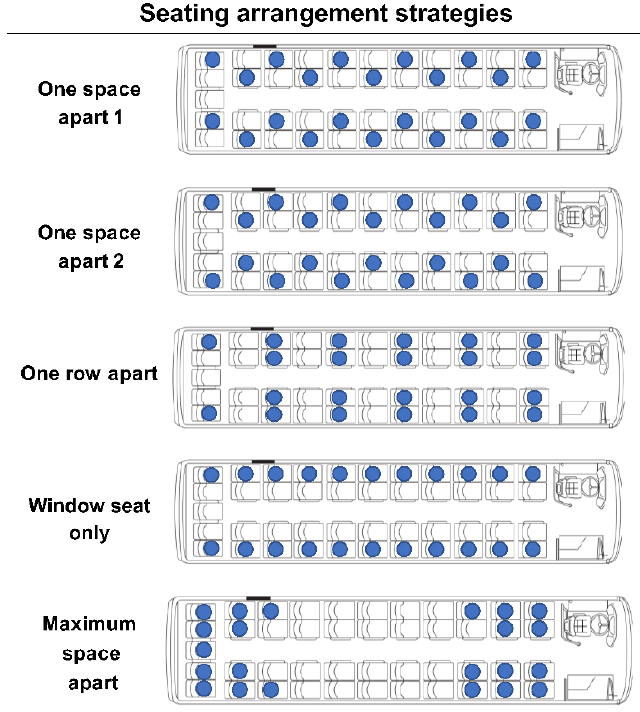
Figure 8. Seating arrangement strategies.